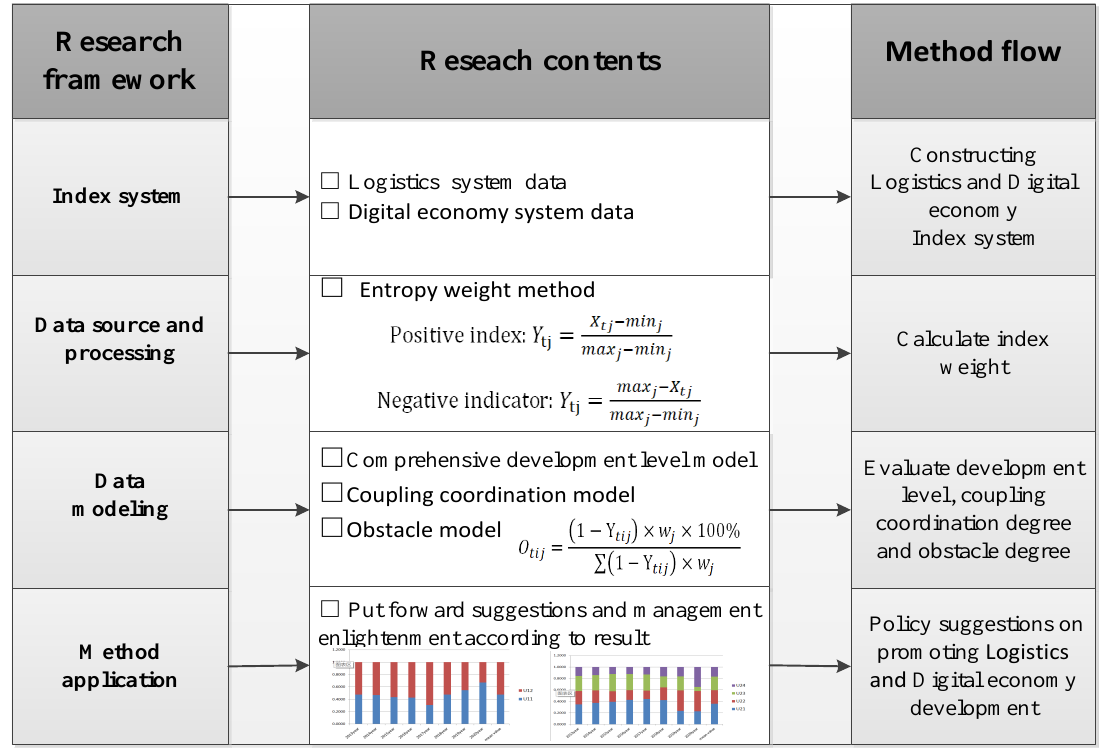
Figure 1. Method flow chart.